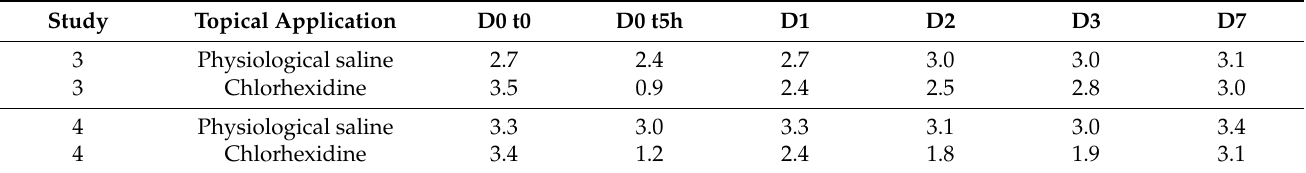
Table 2. Changes to median bacterial densities (CFU/cm 2 ) over time, expressed on a log-scale. Samples were taken at initial time (D0 t0), and after 5 h (D0 t5h), 1 day (D1), 2 days (D2), 3 days (3D), and 7 days